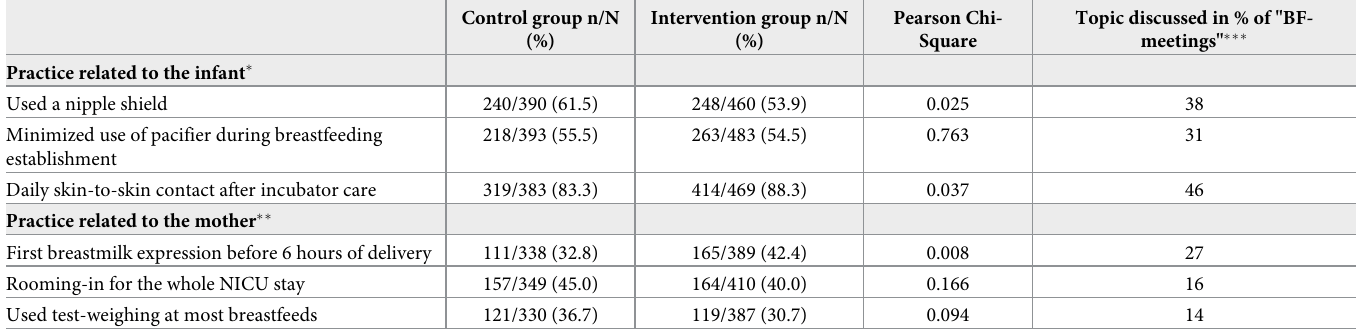
Table 3. Maternal self-reported practices in control and intervention